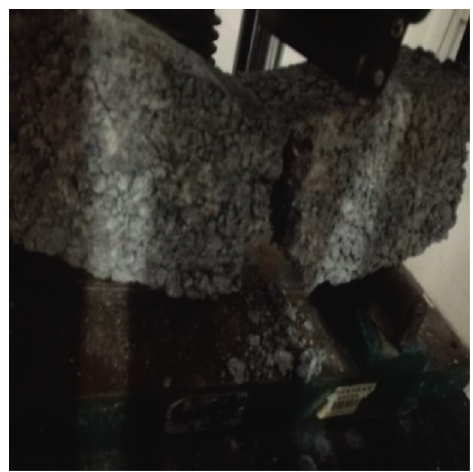
Figure 6: Bending tensile specimens after